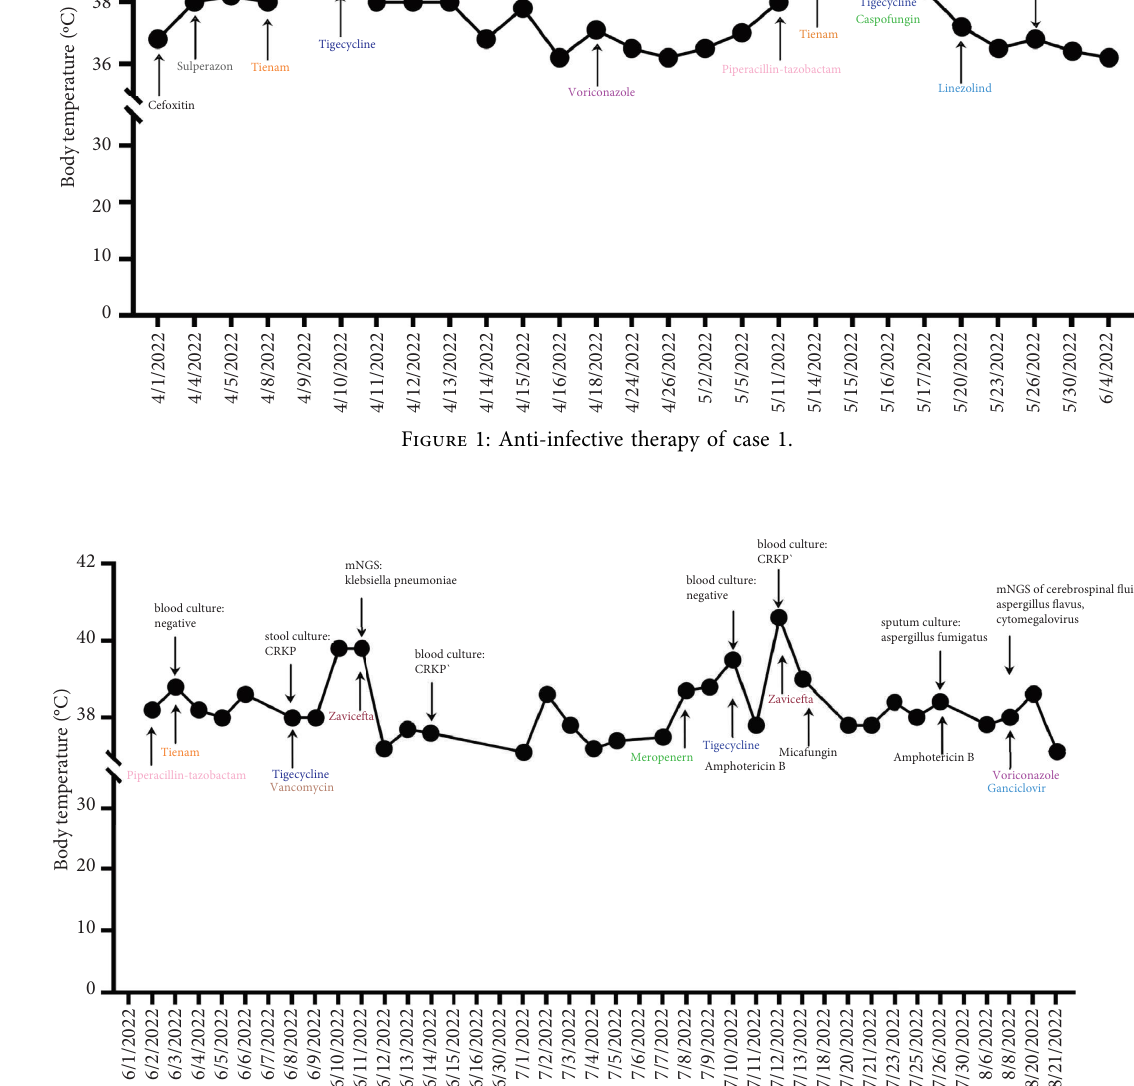
Figure 2: Anti-infective therapy of case 2.